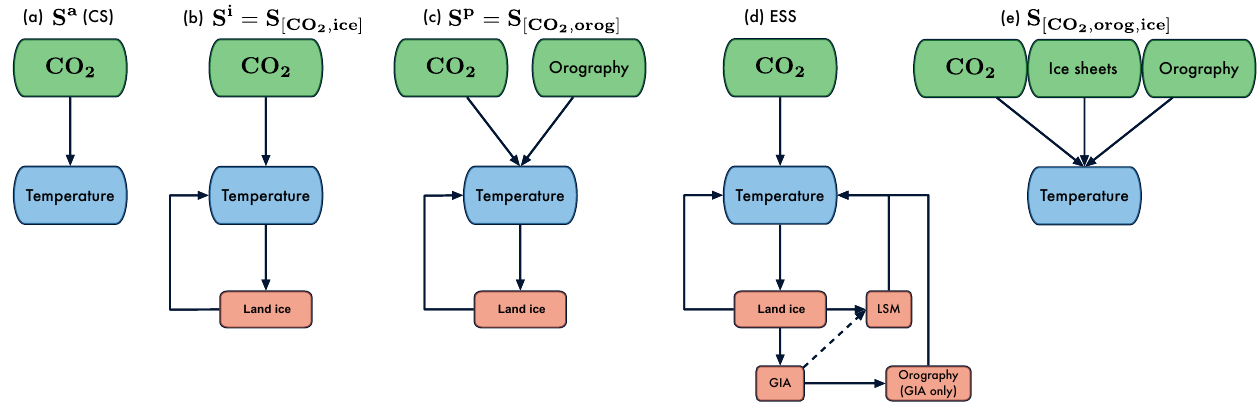
Figure 11. Schematic representations of various measures of climate sensitivity. Forcings are denoted in green, whereas the slow internal feedbacks are shown in orange. See main text for